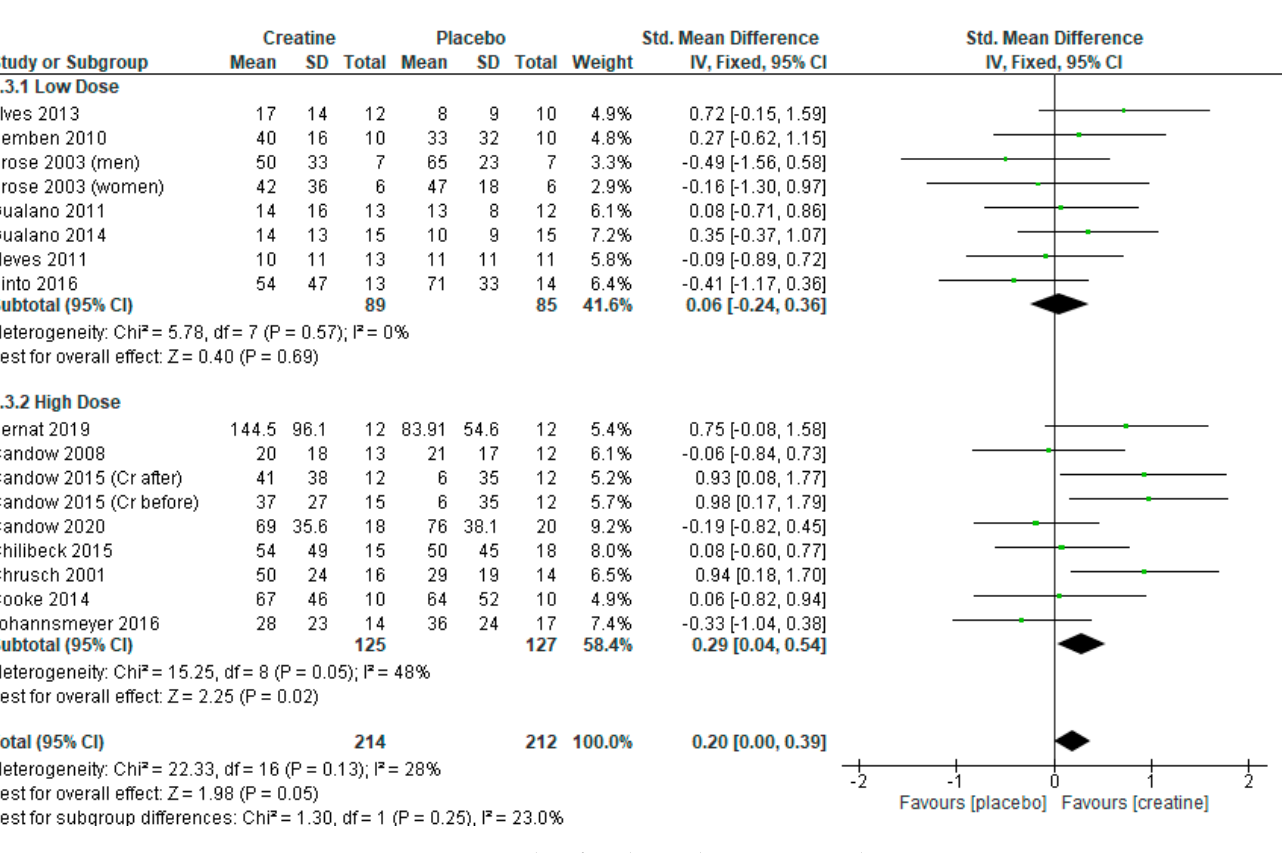
(Figure 6: mean difference = 1.73 kg [95% CI: 0.87, 2.89] p < 0.0001), chest press strength (Figure 7: standard mean difference = 0.58 [95% CI: 0.20, 0.96] p = 0.003), and leg press strength (Figure 8: standard mean difference = 0.44 [95% CI: 0.06, 0.81] p = 0.02).